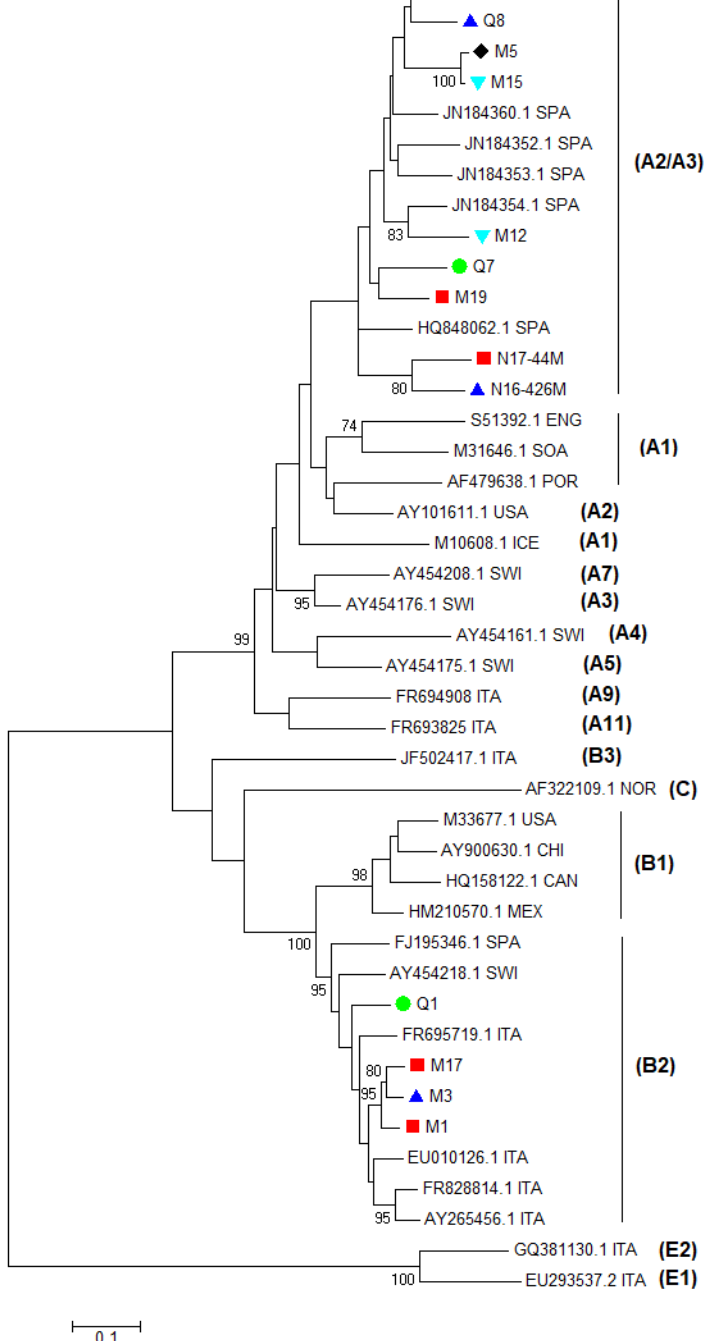
Figure 3. Phylogenetic analysis of the SRLV partial gag-pol region. Sequences of different SRLV genotypes and subtypes available in GenBank were used as reference isolates. Reference sequences are indicated with their accession number and country of origin (CAN: Canada; CHI: China; ENG: England; ICE: Iceland; ITA: Italy; MEX: Mexico; NOR: Norway; POR: Portugal; SOA: South Africa; SPA: Spain; SWI: Switzerland; USA: the U.S.A.). Samples are indicated with their codes and are labeled on the basis of the score of the mammary lesions observed ( ▲ severe, ■ moderate, ▼ minimal, ● no lesions, ♦ not available). The evolutionary history was inferred by using the Maximum Likelihood method based on the General Time Reversible model with a gamma distribution with invariant sites and with bootstrap values based on 1000 repetitions. The tree is unrooted.